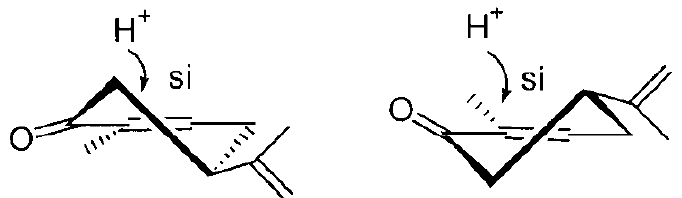
Figure 7. Hydrogen atom attack to C-1 atom during the bioreduction of (4 R )-(–)-carvone ( 1 ) and (4 S )-(+)-carvone ( 6 ), respectively.